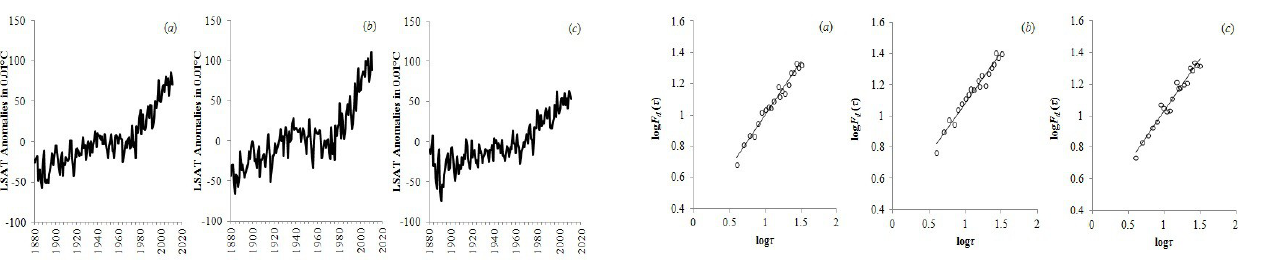
Fig. 1. Annual LSAT anomalies in 0.01 ◦ C, during the period 1880– 2011, (a) globally, (b) over the NH and (c) over the SH.